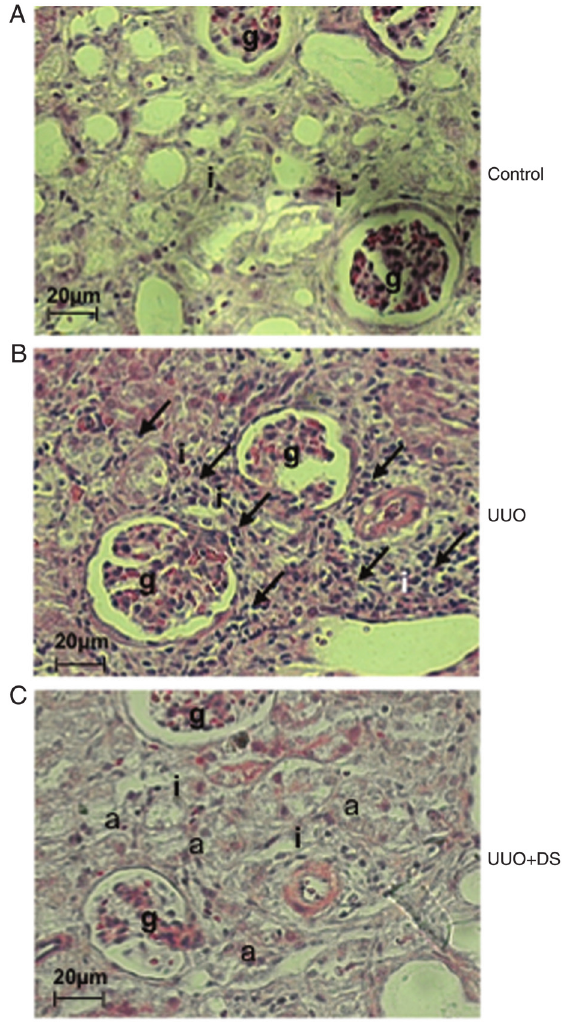
Figure 1. Histochemical analysis of hematoxylin-eosin (HE)- stained sections from obstructed kidneys of mice submitted to dermatan sulfate (DS) treatment. A , HE-stained section from the control group. B , HE-stained section from the group with unilat- eral ureteral obstruction (UUO, obstructed kidney with no treat- ment). C , HE-stained section of obstructed mouse kidneys from the group with unilateral ureteral obstruction plus dermatan sul- fate (UUO+DS, obstructed kidney treated with 4 mg·kg -1 ·day -1 DS for 14 days). Arrows indicate inflammatory cells in the inter- stitium. Note the reduced inflammatory cells in the interstitium of obstructed kidney from animals of group UUO+DS (a). g = glom- erulum; i = interstitium. Scale bar = 20 µm. Magnification